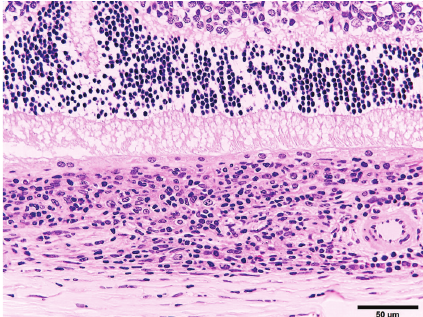
Figure 4: Photomicrograph of the choroid of the eye from a 50-week-old female SDT fatty rat. There is diffuse infiltration of inflammatory cells in the choroid. Inflammatory cells are partly spreading to the surrounding area in the sclera. Bar = 50 𝜇 m. Hematoxylin and eosin.